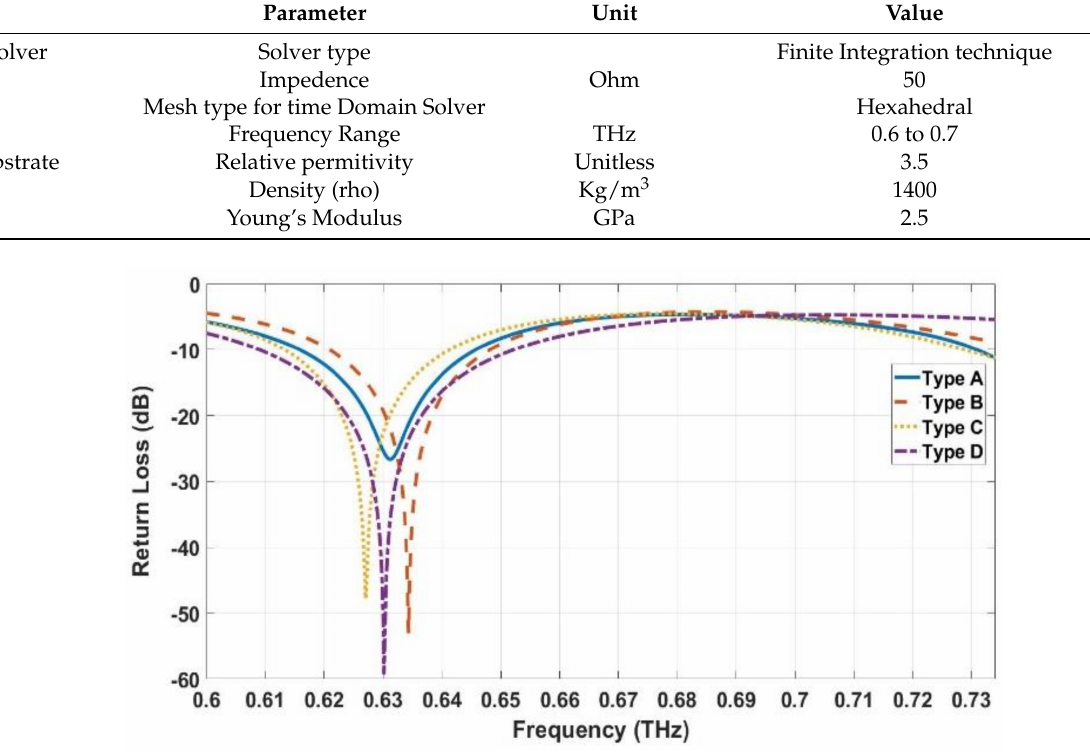
Figure 4. Comparison of return